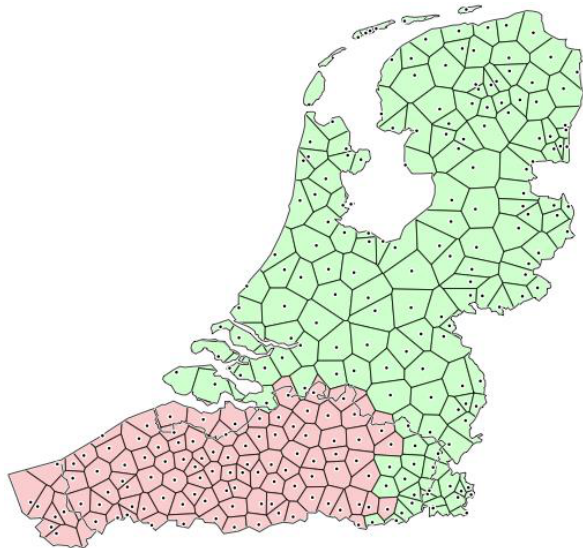
Figure 3. Voronoi diagram for geographic data with region boundaries 3 . The boundaries limit the Voronoi cells to reasonable sizes. However, not every data set corresponds with